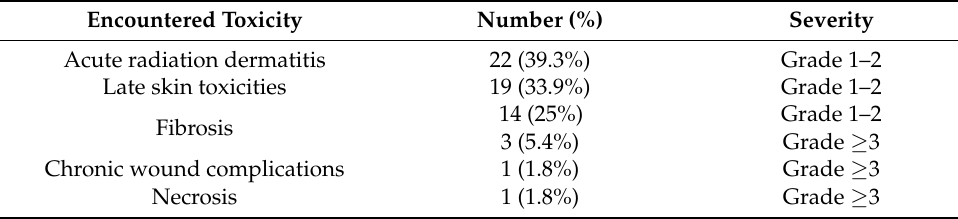
Table 3. Treatment-related